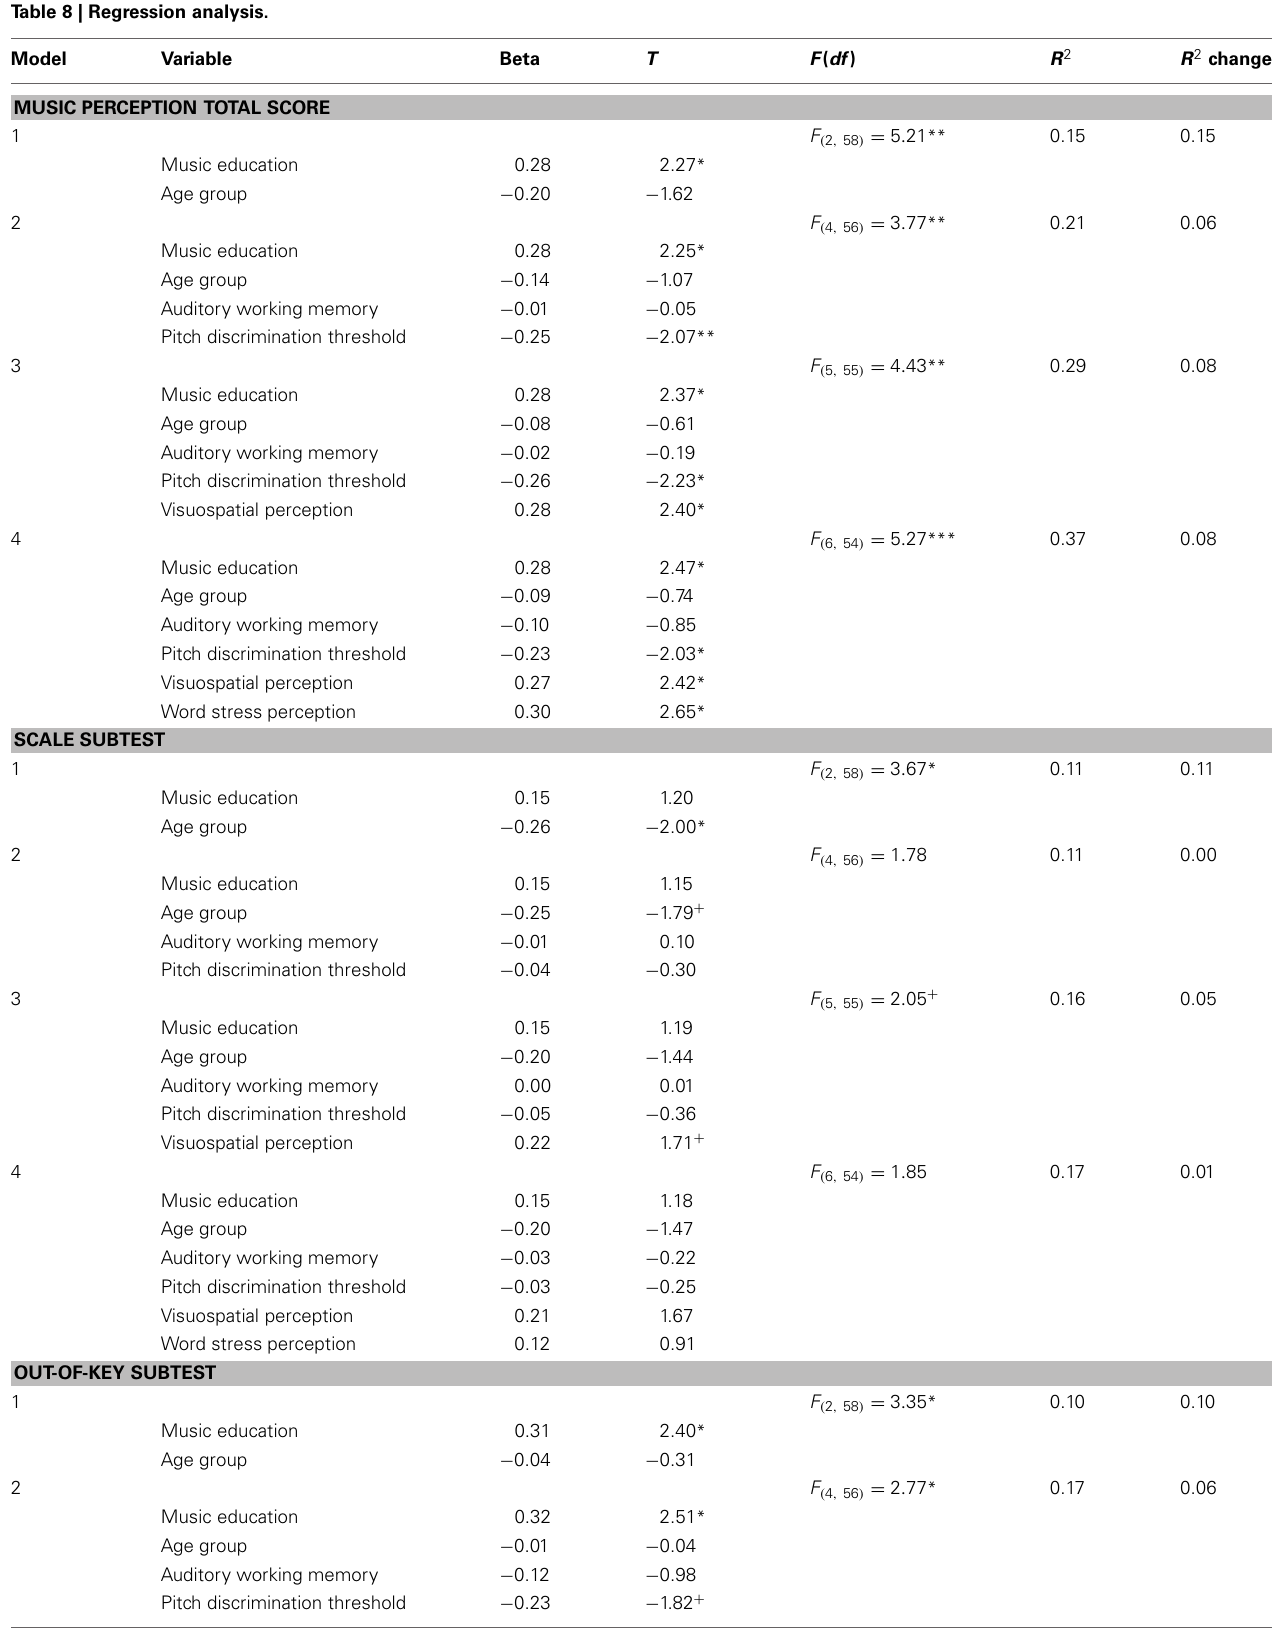
Table 8 | Regression